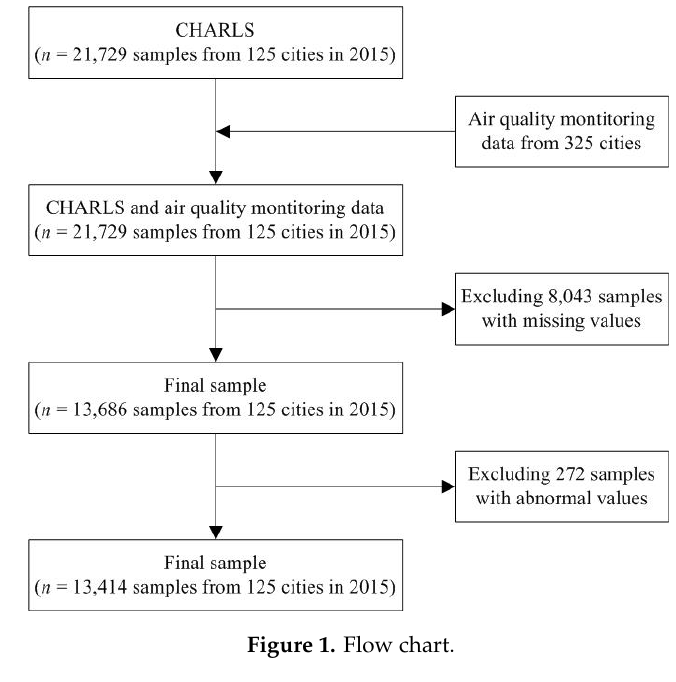
Figure 1. Flow chart.